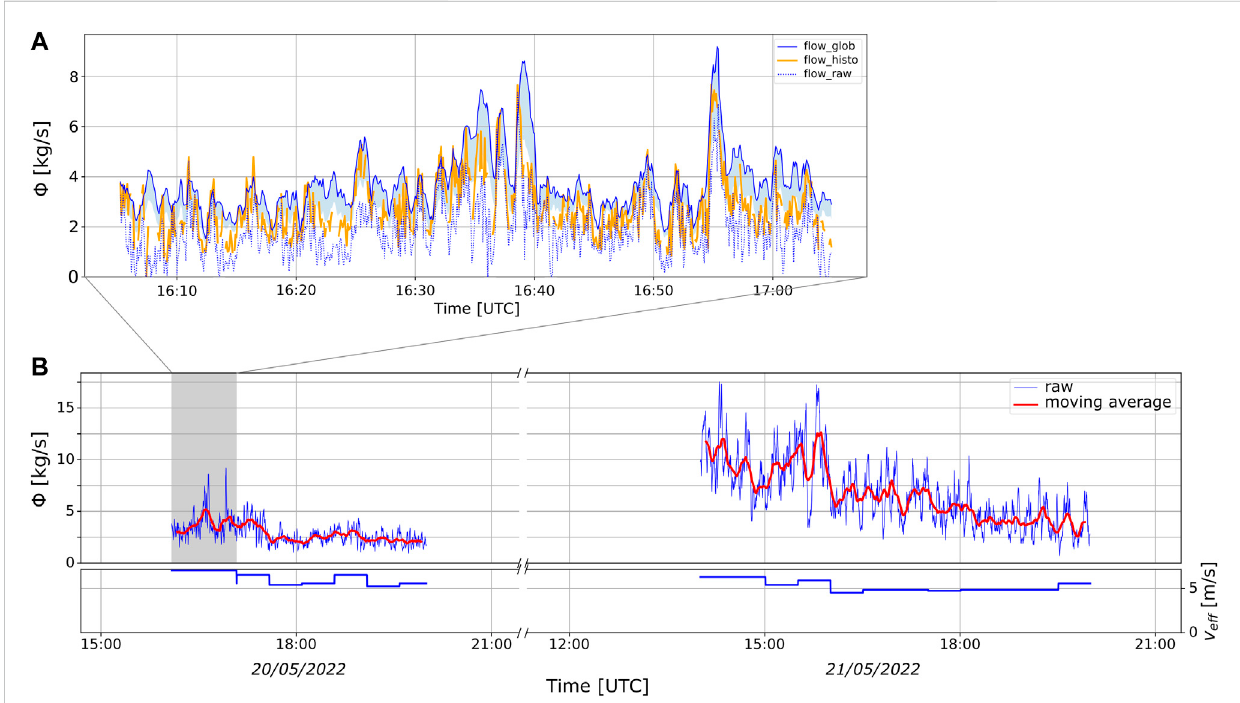
FIGURE 8 (A) Emissionrate( Φ )timeseriesasinFigure6butcorrectedforlightdilution.Blueshadedregionshowsthedifferencebetweentheuncorrectedand corrected emission rates for the fl ow_glob series. (B) A longer-term series spanning 20th-21st May based on fl ow_glob plume speeds (blue) with a 10- min moving average (red). Plume speed ( v eff ) is also displayed and is relatively consistent across the 2 days, unlike the emission rate which is signi fi cantly higher on the